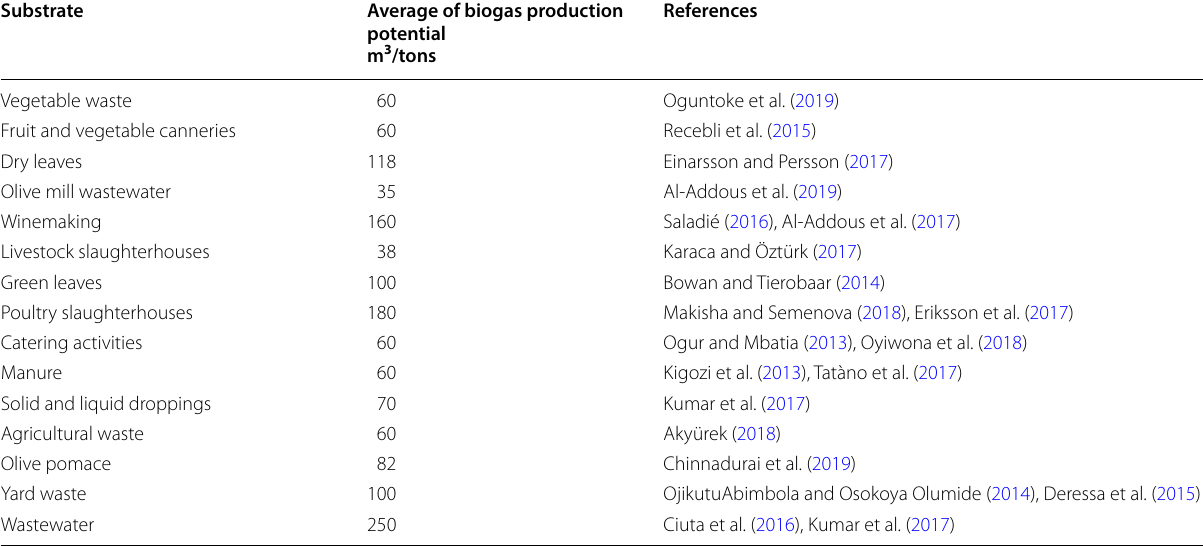
Table 2 Potential of biogas from deferent substrate Substrate